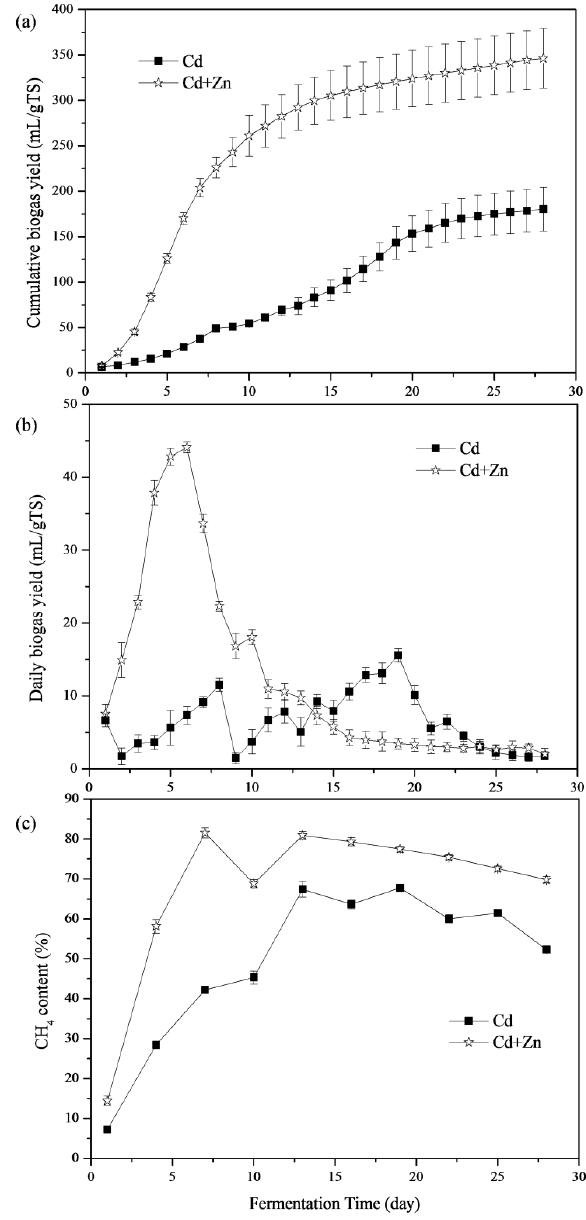
Figure 2. Cumulative biogas yields ( a ), daily biogas yields ( b ), and CH 4 contents ( c ) in response to Cd and Cd+Zn during the fermentation.